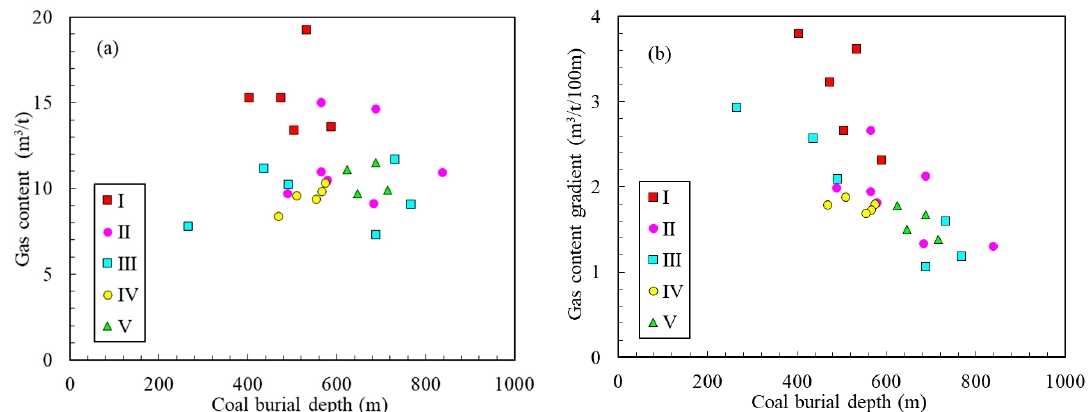
Figure 7. Gas content ( a ) and gas content gradient ( b ) vary with coal burial depth. Gas controlling pattern: I—reverse fault sealing type, II—syncline sealing type, III—monoclinal enrichment type, IV—normal fault dispersion type, V—buried floor fault dispersion type.